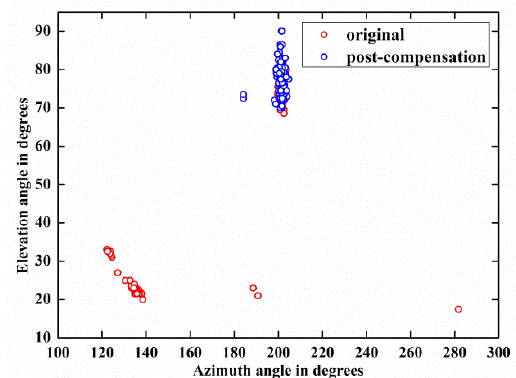
Figure 15. Azimuth-elevation angle estimation results comparison between weak target signal-2 before and after compensation.